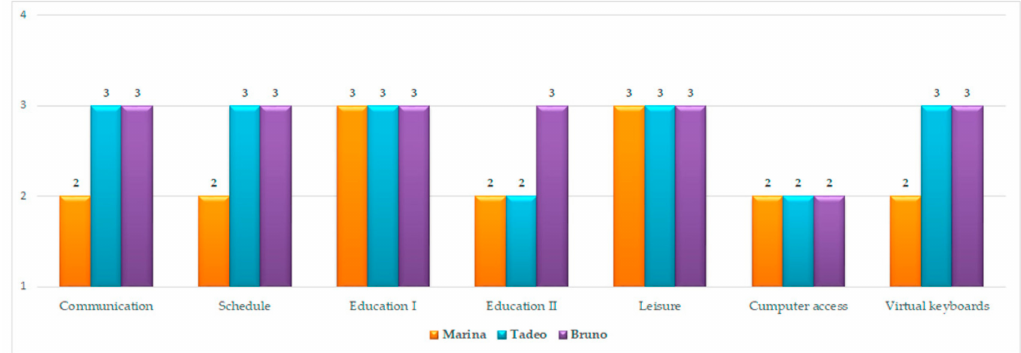
Figure 4. Scores obtained in the observation of the children’s interactions with the